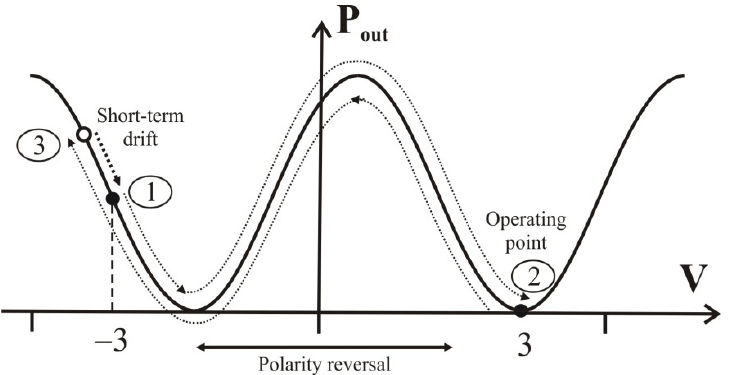
Figure 4. Mechanism of short-term DC-drift measurements.